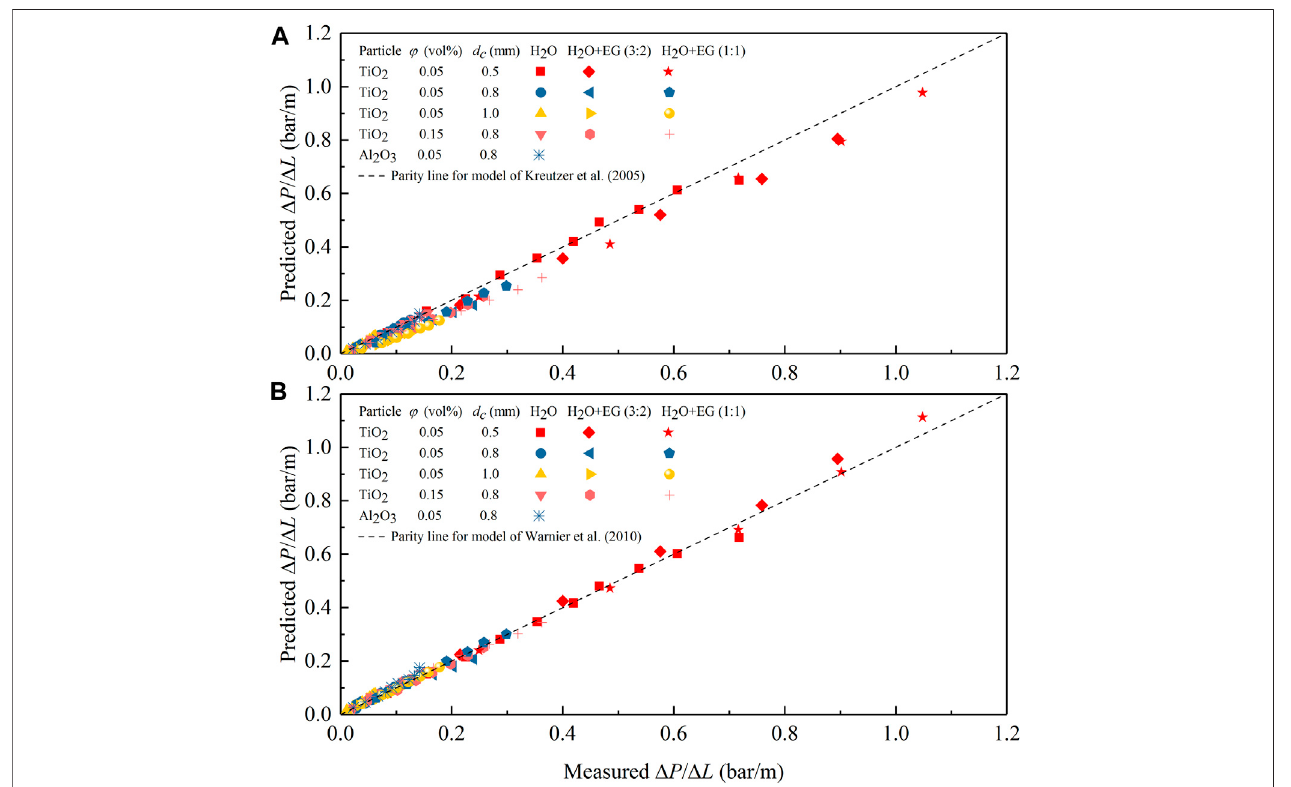
FIGURE 12 | Comparison between the measured pressure drop data for N 2 -nano fl uid slug fl ow in the microchannel and predictions according to the model of Kreutzer et al. (2005) (A) and Warnier et al. (2010) (B) .